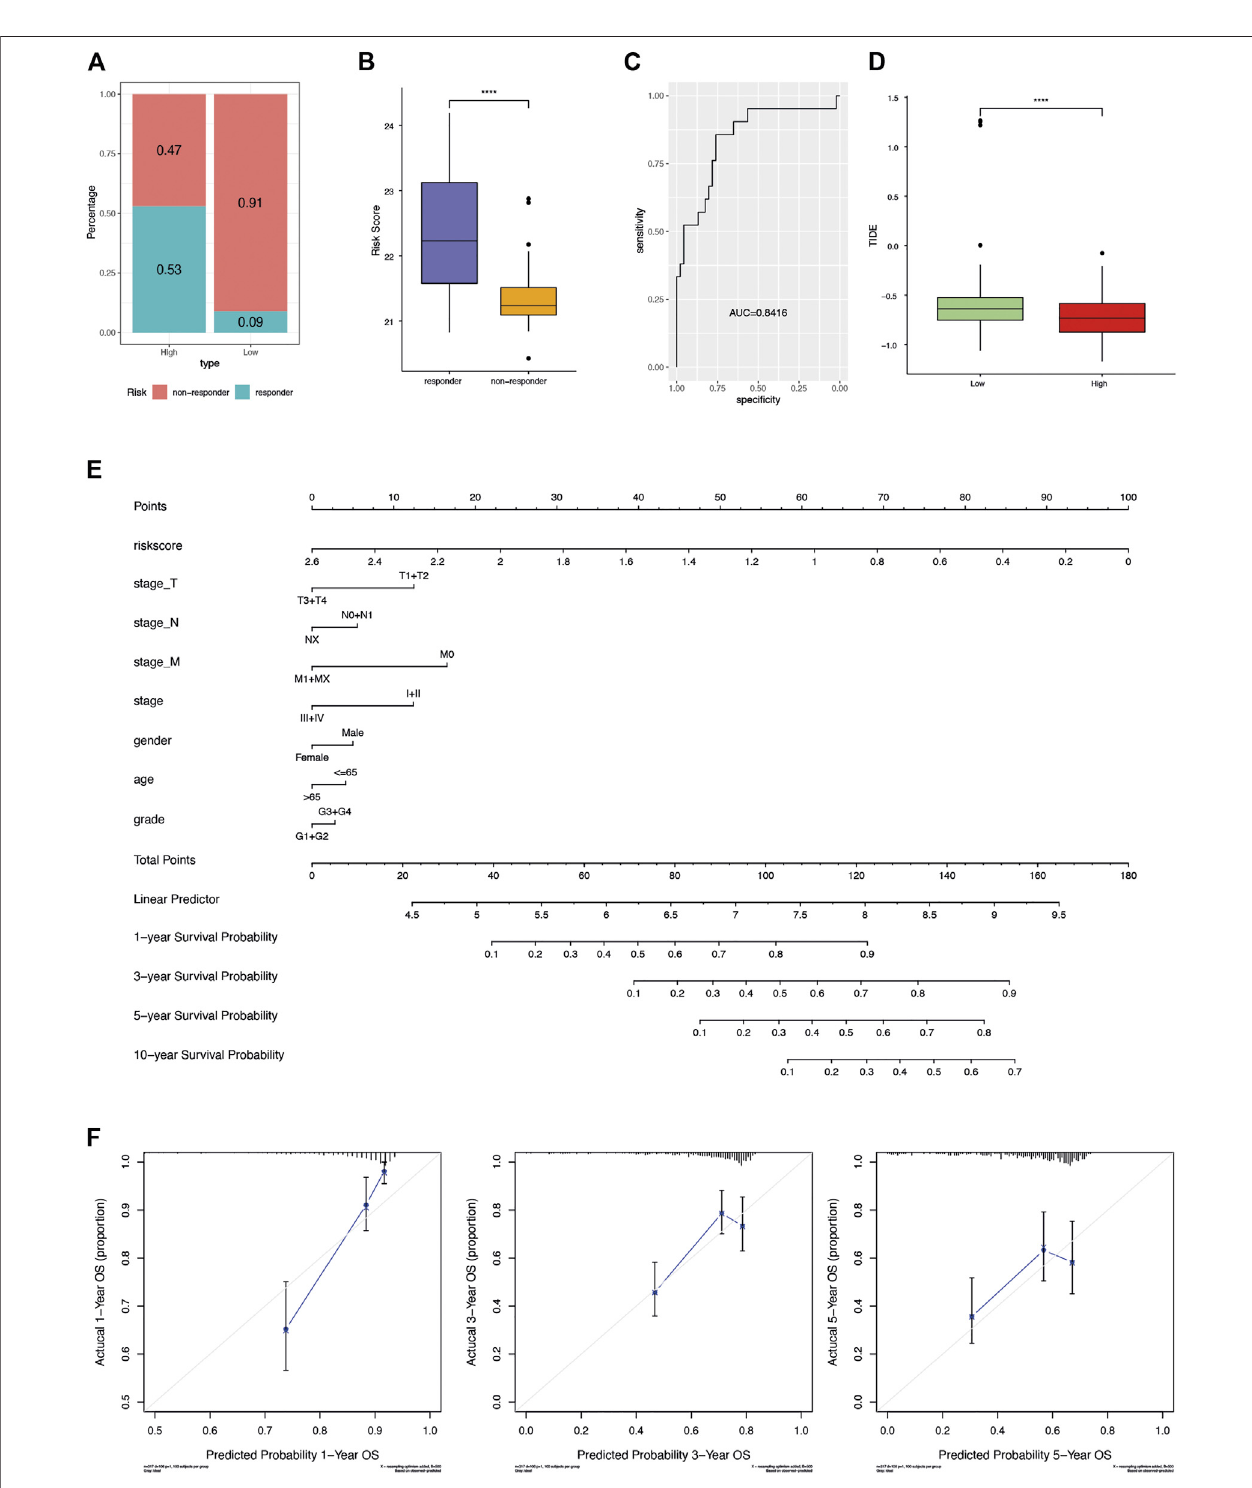
FIGURE6| Potentialclinical application ofAFsriskscore. (A) Theproportionofsamplesresponding tosorafenibinterms ofthehigh-and low-riskgroups. (B) The distribution of risk score between sorafenib responders and non-responders. (C) The ROC curve showed the sensitivity and speci fi city of risk score in predicting sorafenib response. (D) Boxplot compared the distribution of TIDE score between the high- and low-risk groups. (E) Nomogram-based AFs-derived prognostic model and clinical factors for 1-, 3-, 5- and 10-years OS prediction. (F) Calibration plot for agreement test between 1-, 3- and 5-years OS prediction and actual